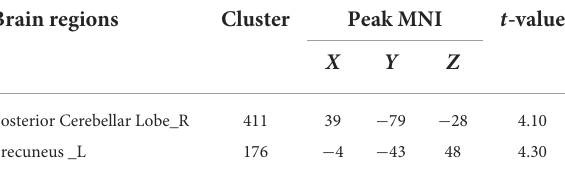
TABLE 5 Brain regions with a significantly decreased volume of gray matter in NMDARE_SD compared to NMDARE_LD. Brain regions Cluster Peak MNI t -value X Y Z Posterior Cerebellar Lobe_R 4.10 176